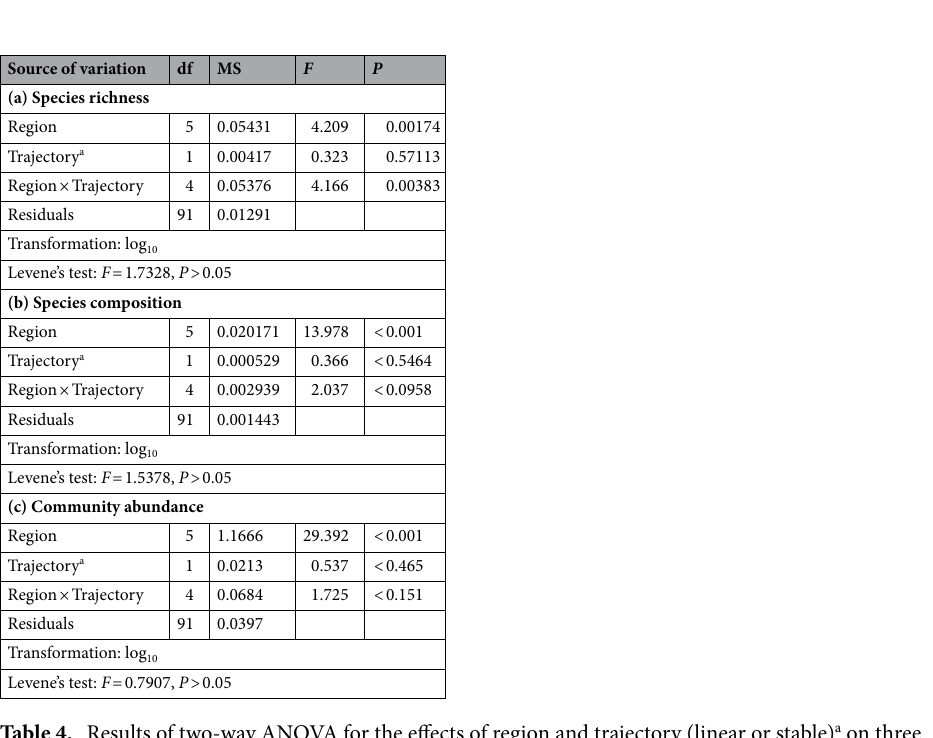
Table 3. Results of multiple regression analysis for the effects of current systems and strength of current fluctuations on model coefficients of each trajectory type (linear [α]; stable [ of community temporal invariability (species richness, species composition, and community abundance). Columns report the estimated coefficients for explanatory variables, their standard errors, t-values and P -values.